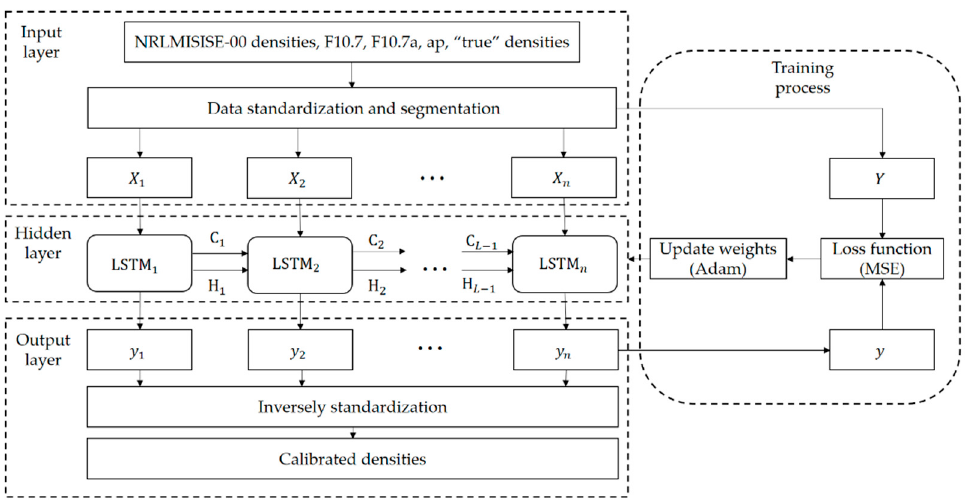
Figure 2. The structure of the LSTM-NRL calibration model.